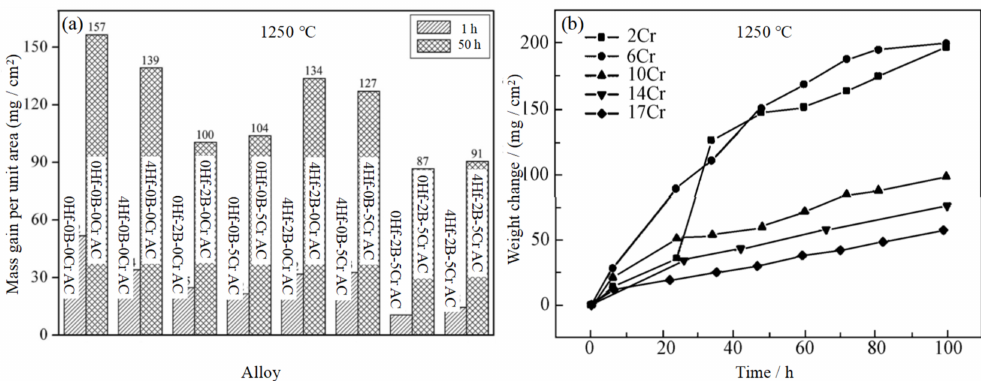
Figure 5. ( a ) Oxidative weight gain histogram of the Nb-Si-based alloys oxidized at 1250 ◦ C. ( b ) The oxidation weight gain curve of Nb-Si alloy with different Cr content at 1250 ◦ C. Copyright 2012 Elsevier and 2015 Elsevier.